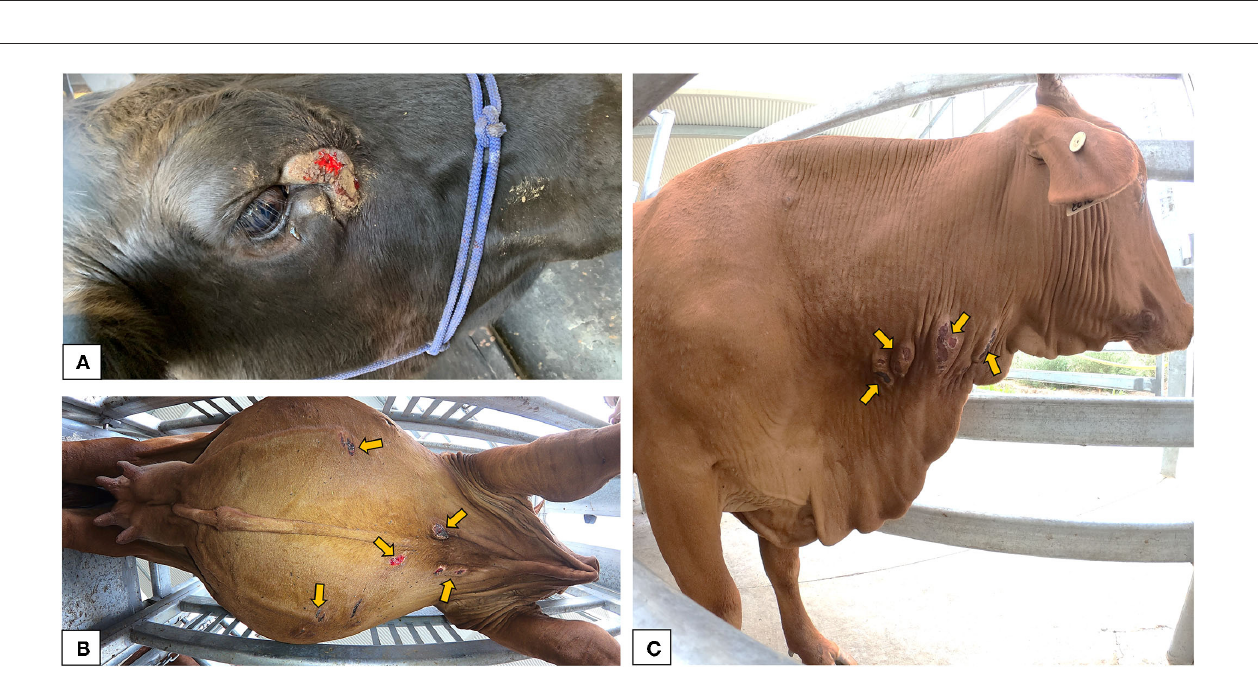
FIGURE3 Gross appearance of the buffalo fly lesions: (A) lesion adjacent to the medial canthus of the eye in a Brangus steer indicating raised, circumscribed, hairless, ulcerative area partially covered with scab forming from the periphery; (B) multiple ulcerative to scab encrusted lesions near the ventral midline of a Droughtmaster cow; (C) multiple raised scabbed lesions on the neck of a Droughtmaster